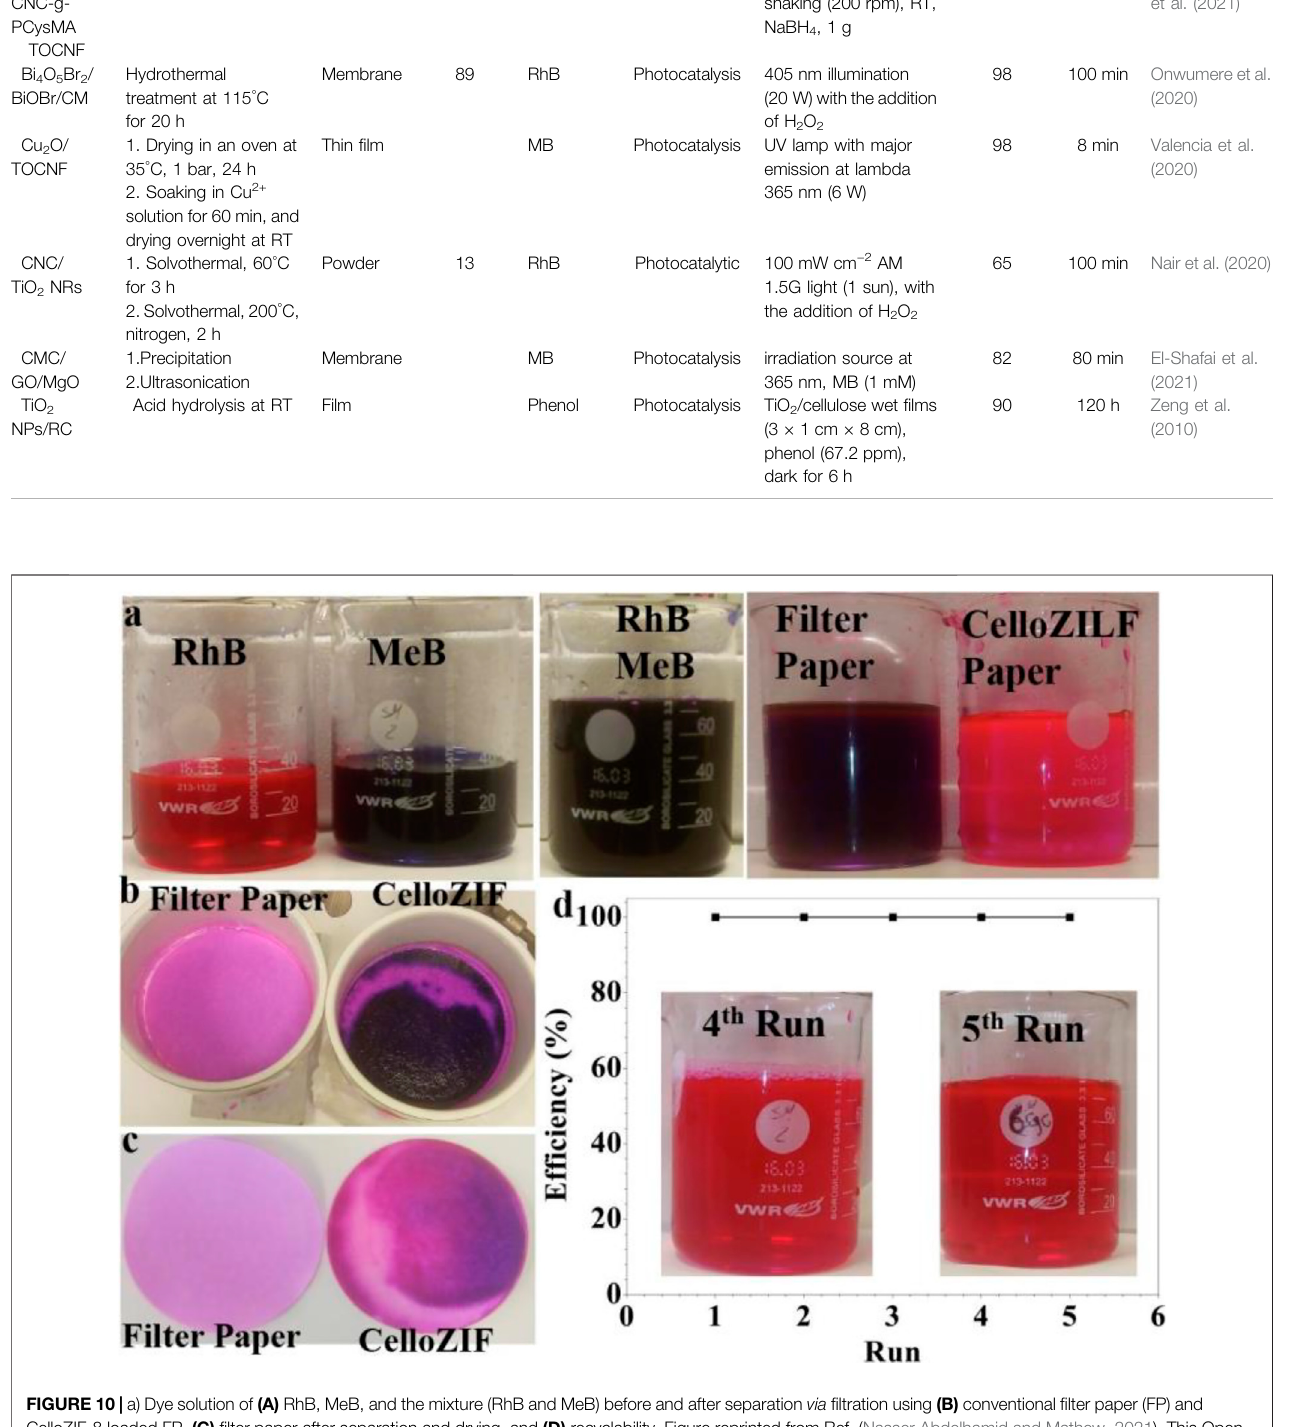
FIGURE 10 | a) Dye solution of (A) RhB, MeB, and the mixture (RhB and MeB) before and after separation via fi ltration using (B) conventional fi lter paper (FP) and CelloZIF-8 loaded FP, (C) fi lter paper after separation and drying, and (D) recyclability. Figure reprinted from Ref. (Nasser Abdelhamid and Mathew, 2021). This